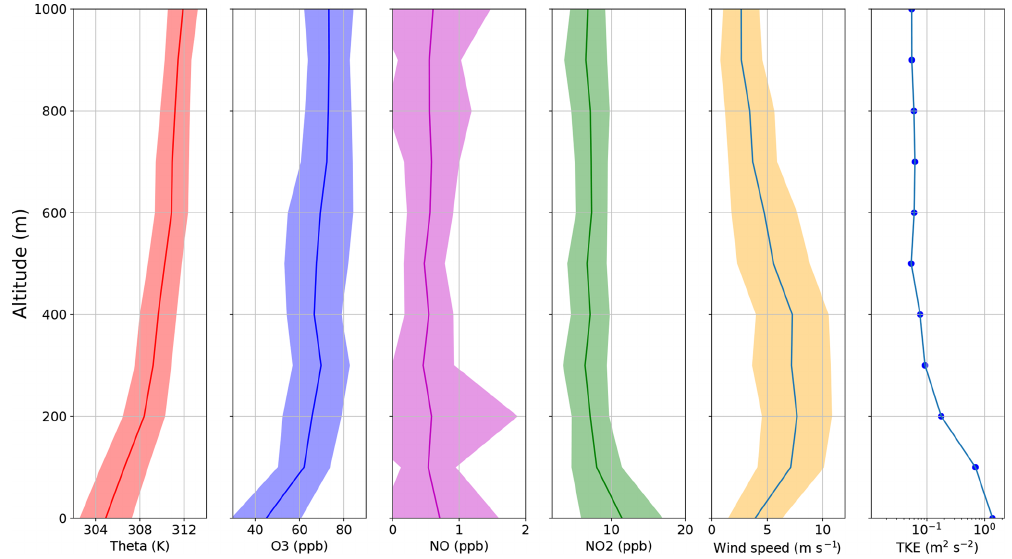
Figure 4. Mean and ± 1 standard deviation (swathes) of potential temperature, ozone, NO, NO 2 , wind speed, and turbulent kinetic energy (mean only) from all late-night flights. Table 1. NBL heights, ozone, NO 2 , Brunt–Väisälä (BV) frequencies, bulk Richardson number (BRN), turbulent kinetic energy (TKE), and from the following day and are an average of the 11 ground networks in our flight